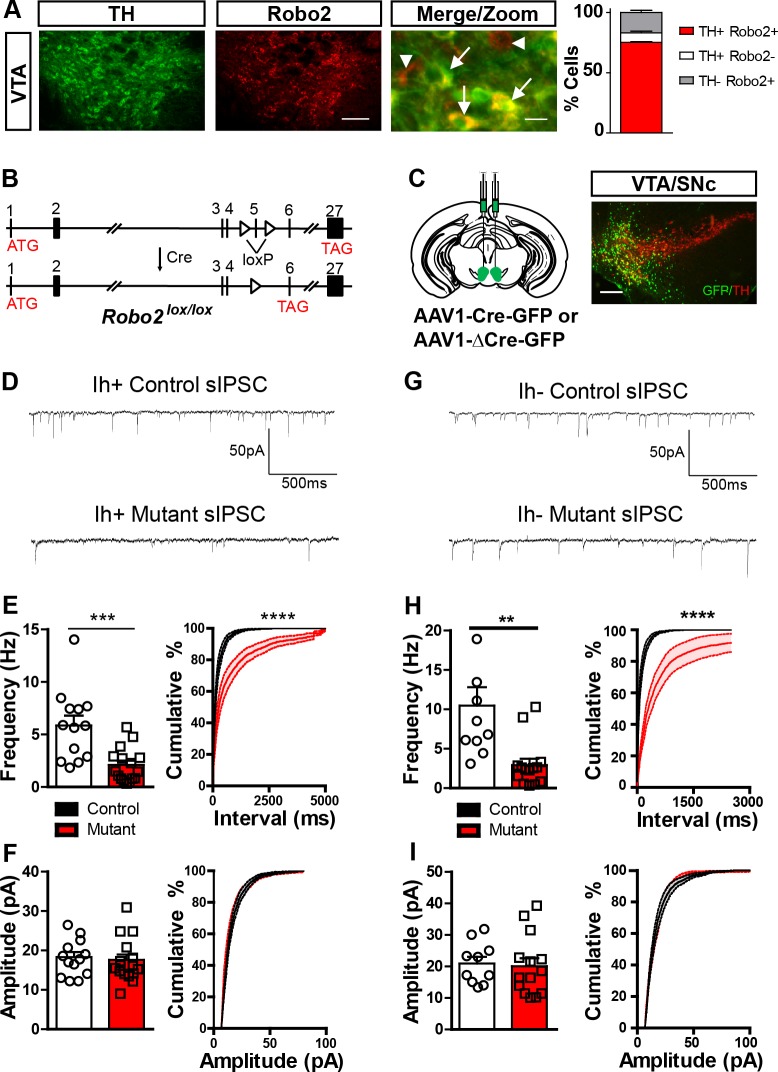
Robo2 VTA mutants have a reduction in the frequency of sIPSCs.(A) Robo2 is expressed in the VTA, predominantly in dopamine neurons (TH+ cells, arrows), but also non-dopamine neurons (TH- cells, arrowheads). Scale bar = 100 µm (Robo2), 10 µm (merge/zoom). (B) The genomic structure of the Robo2lox/lox allele before and after Cre recombination, adapted from Lu et al. (2007). (C) Schematic of strategy to virally inactivate Robo2 in the VTA (left). Representative image (right) showing expression of Cre-GFP and TH in the VTA. Scale bar = 100 µm. (D) sIPSC representative traces for control and mutant Ih positive cell. (E) sIPSC frequency (left) and cumulative distribution plot (right) for control (n = 13) and mutant (n = 16) Ih positive cells. Unpaired t-test, t(27) = 3.944, ***p<0.001. Two-way repeated measures ANOVA, genotype x time interaction, F(27,100) = 17.30, ****p<0.0001. (F) sIPSC amplitude (left) and cumulative distribution plot (right) for control and mutant Ih positive cells. (G) sIPSC representative trace for control and mutant Ih negative cell. (H) sIPSC frequency (left) and cumulative distribution plot (right) for control (n = 10) and mutant (n = 14) Ih negative cells. Unpaired t-test, t(22) = 3.459, **p<0.01. Two-way repeated measures ANOVA, genotype x time interaction, F(22,100)=11.40, ****p<0.0001. (I) sIPSC amplitude (left) and cumulative distribution plot (right) for control and mutant Ih negative cells. Bars represent mean ± SEM.